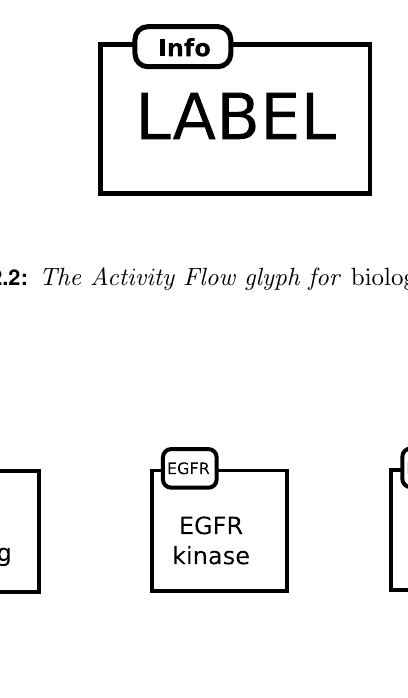
Figure 2.3: An example of Activity Flow glyphs of EGFR activities. Since EGFR protein has both binding and kinase activities, each of those activities can be represented by different nodes, labeled as EGFR binding and EGFR kinase . One node can be used to represent the overall activity of EGFR . The label in the unit of information indicates the protein that the activities come from. In this example, all three activities come from the same EGFR protein